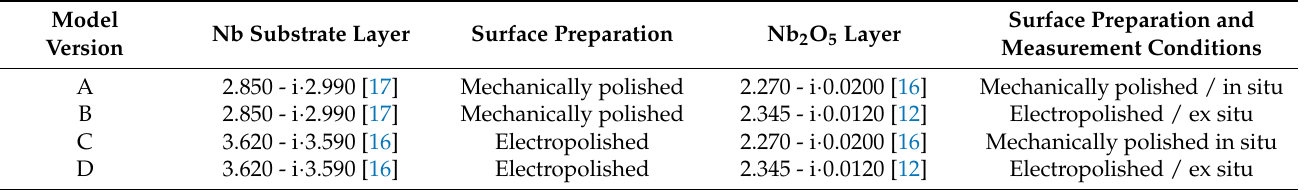
Table 1. Ellipsometric optical constants for Nb and Nb 2 O 5 for single layer model with measurement methodology.